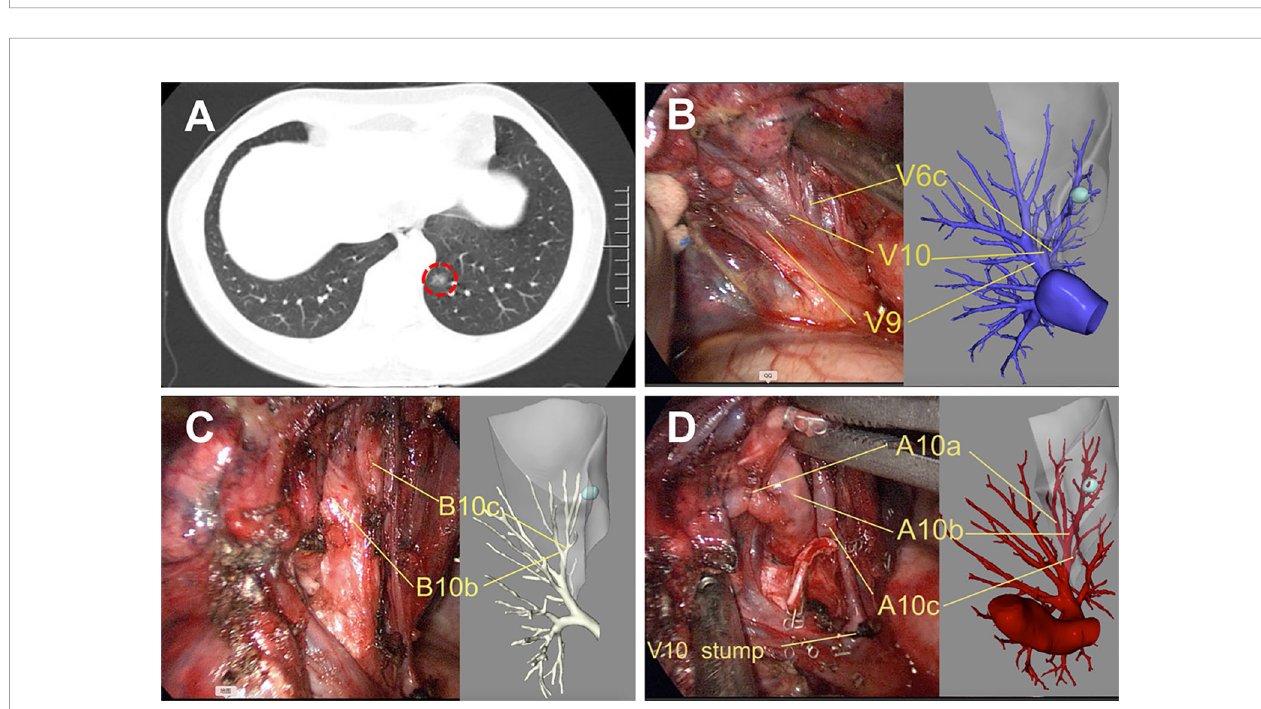
FIGURE 3 | Precise left S 10 segmentectomy according to the real-time 3D reconstruction guidance. (A) CT scan showed a GGOs lesion in the left S 10 ; Branches pulmonary vein (B) , bronchus (C) , and pulmonary artery (D) of the target segment were con fi rmed by real-time guidance of 3D reconstruction. 3D, three-